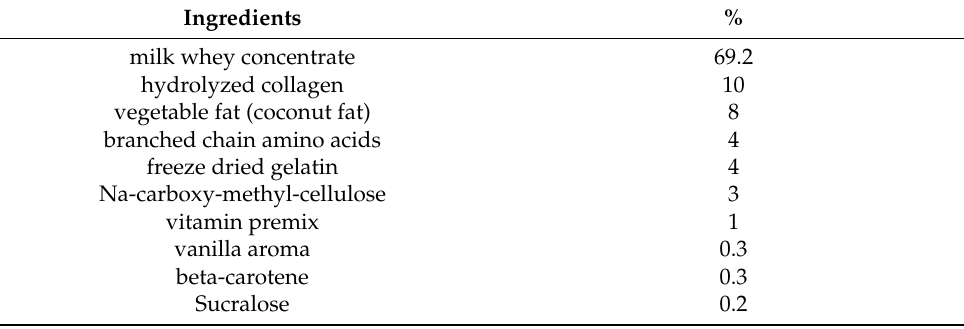
Table 1. Constituents of the commercial vanilla shake powder used in the